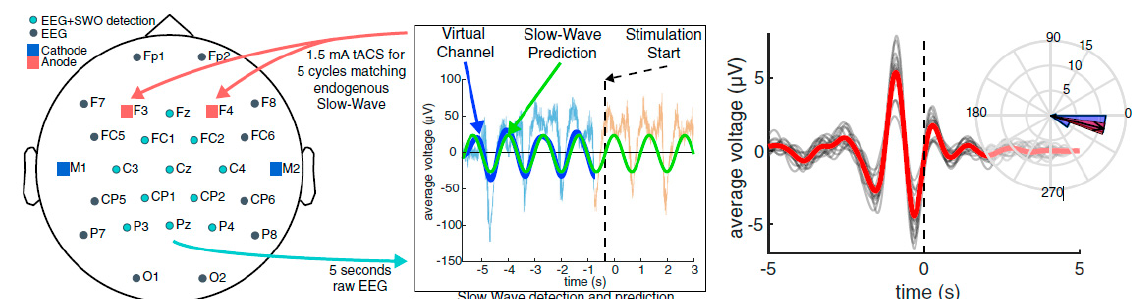
Figure 2. Left—Stimulation montage for closed-loop transcranial alternating current stimulation (CL-tACS) during slow-wave sleep (SWS). Middle/Right—CL-tACS procedure. The virtual electroencephalography (EEG) channel in the 5 s buffer is bandpass filtered in the slow-wave oscillation (SWO) frequency range (0.5–1.2 Hz). If the relative power in the SWO band is >20% of the broadband power across 0.1–250 Hz, a sine wave at the dominant SWO frequency is fit to the filtered virtual channel and projected into the future to predict the time points of the next available UP states. By matching the phase of the tACS to this projected function, the dynamics of tACS and the predicted endogenous signal are aligned. For verum stimulation, 5 cycles of CL-tACS were applied in response to observed SWO events through the sleep. Figure copied from [58] with permission.